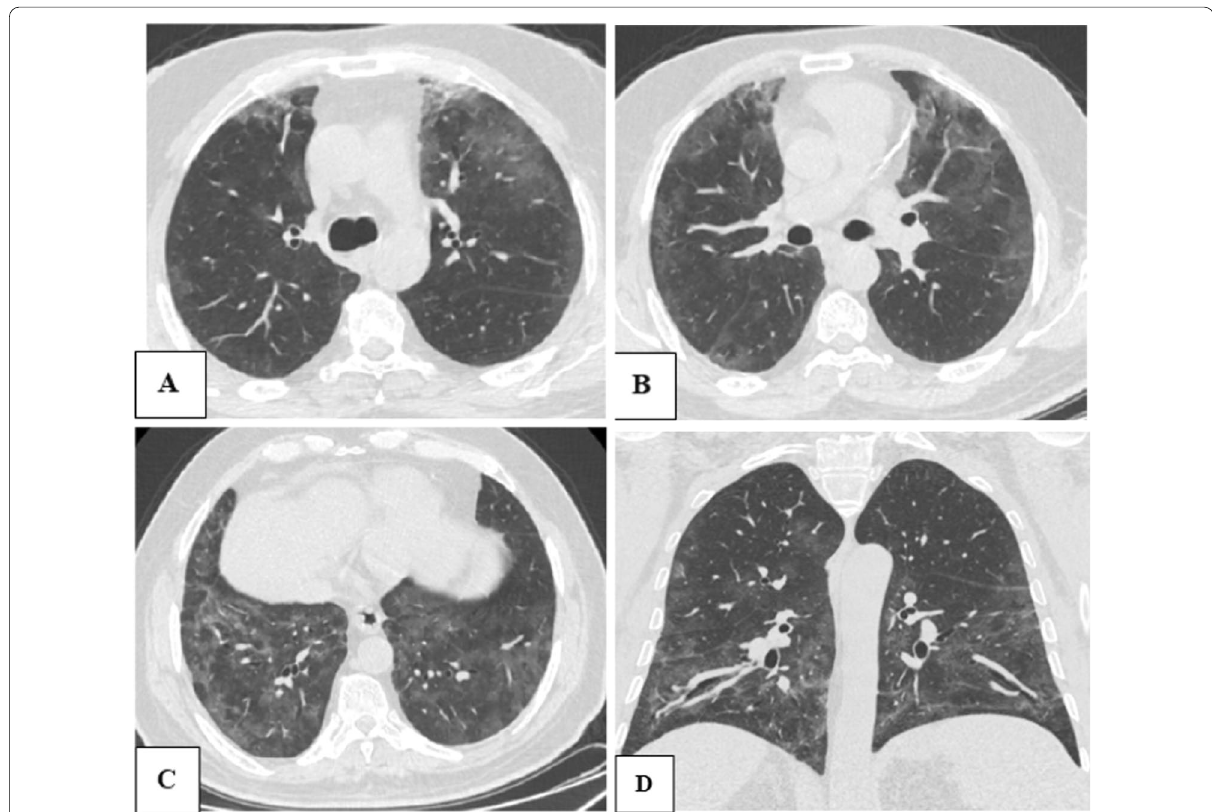
Fig. 3 64-years old male patient, with blood group A, having COVID-19 pneumonia, and referred for CT chest assessment. A – C Axial and D coronal CT chest images shows bilateral sub-pleural variable-sized ground-glass opacities with interlobar septal thickening and crazy paving appearance. Calculated CT severity score was 16 and such case was considered high